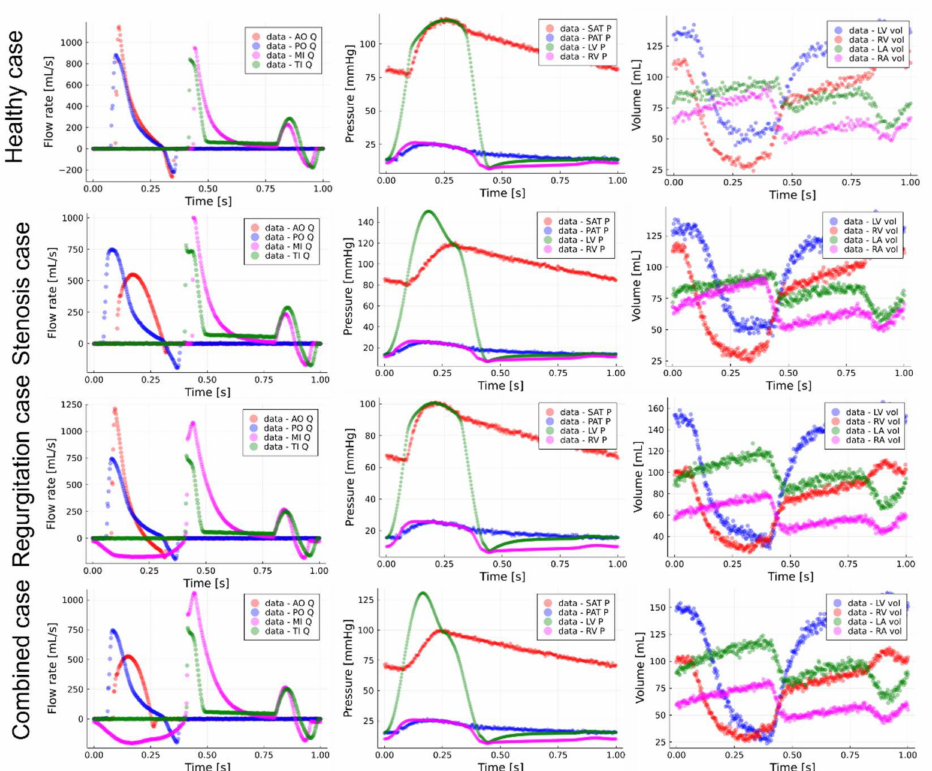
Figure 3. Generated data for different cases. vol—volume; SAT P—systemic arterial pressure; PAT P—pulmonary arterial pressure; LV P—left ventricular pressure; RV P—right ventricular pressure, AO Q—aortic valve flow rate, PO Q—pulmonary valve flow rate, MI Q—mitral valve flow rate, TI Q—tricuspid valve flow